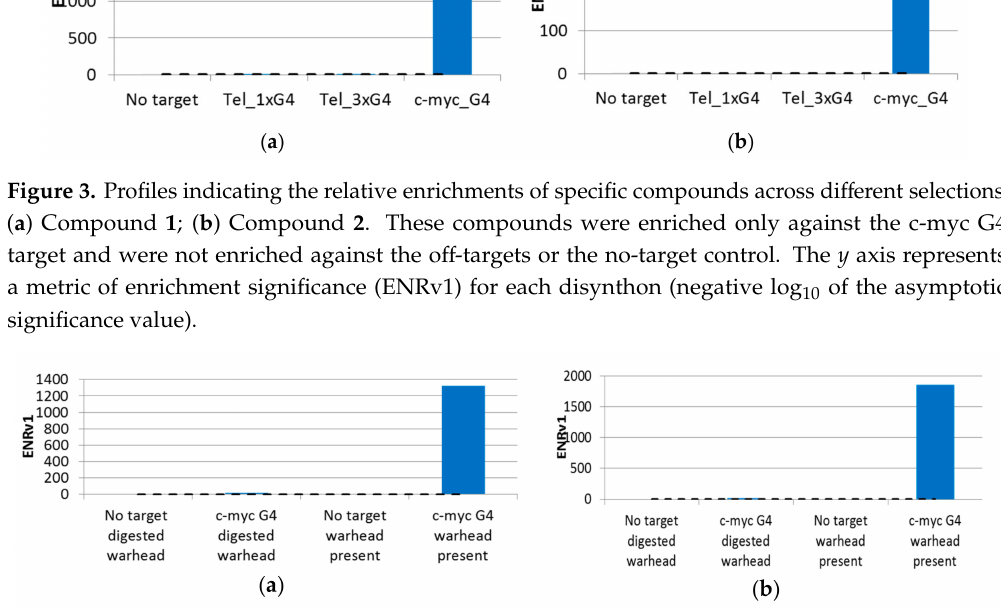
Figure 4. Relative enrichment of compounds with and without a target and with and without an encoded chemical entity: ( a ) Family AA; ( b ) Family BF. Enrichment was observed to be both target- and